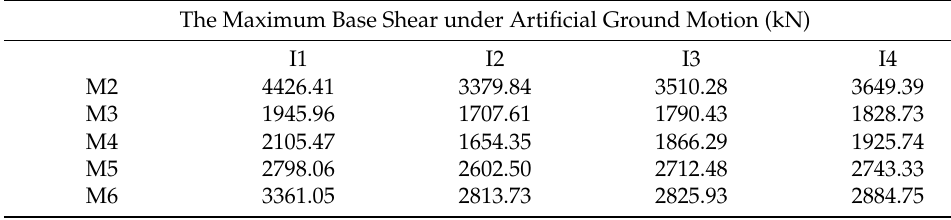
Table 13. The maximum base shear under three ground